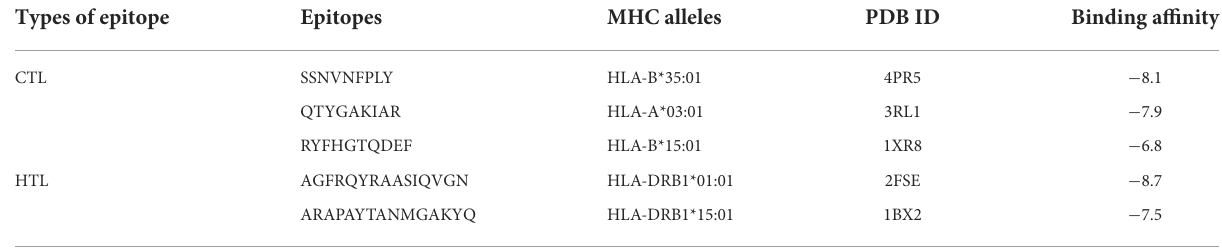
TABLE 2 Molecular docking of T-lymphocyte epitopes with their corresponding MHC alleles and their binding affinity. Types of epitope